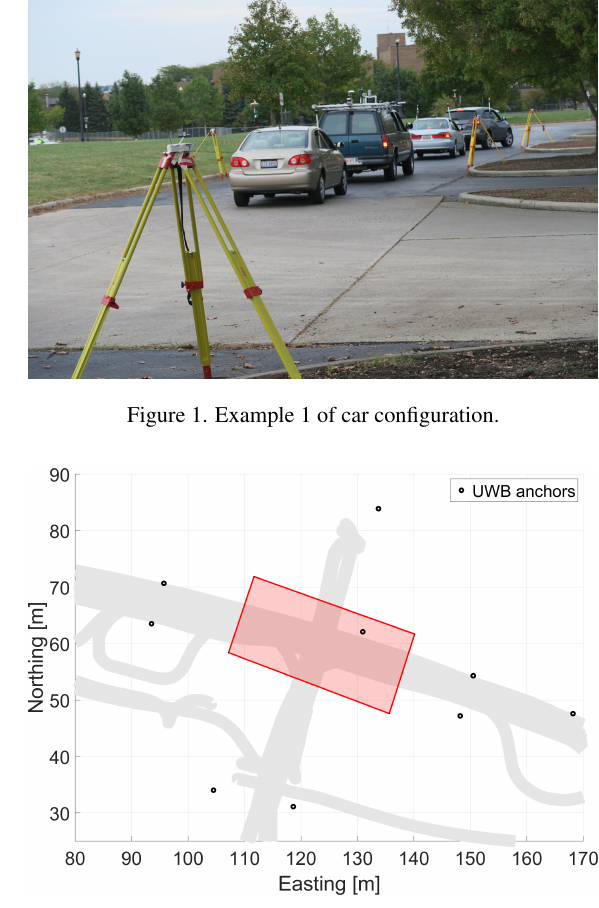
Figure 2. Test area. Red box: main region of interest.